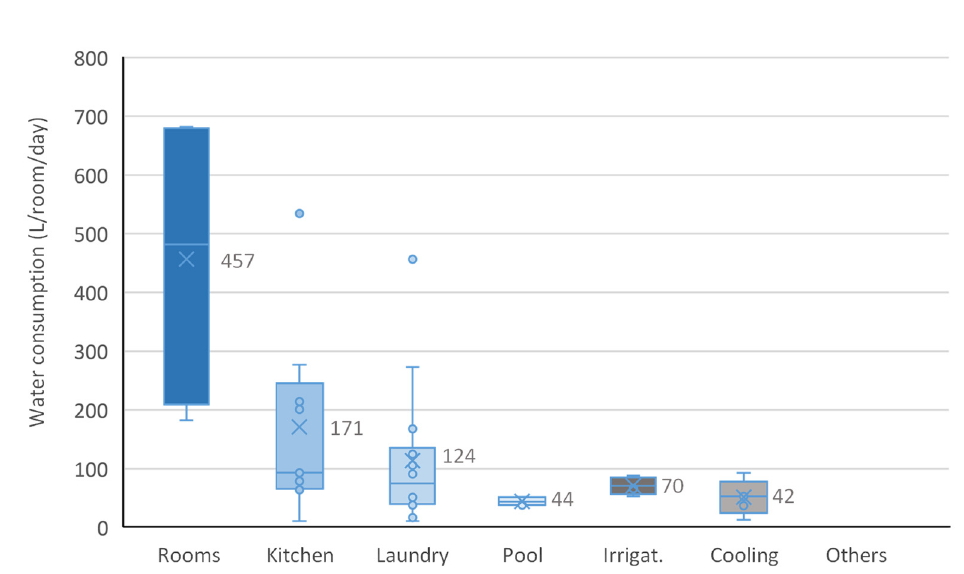
Figure 2. Distribution of daily relative water consumption per micro-component.